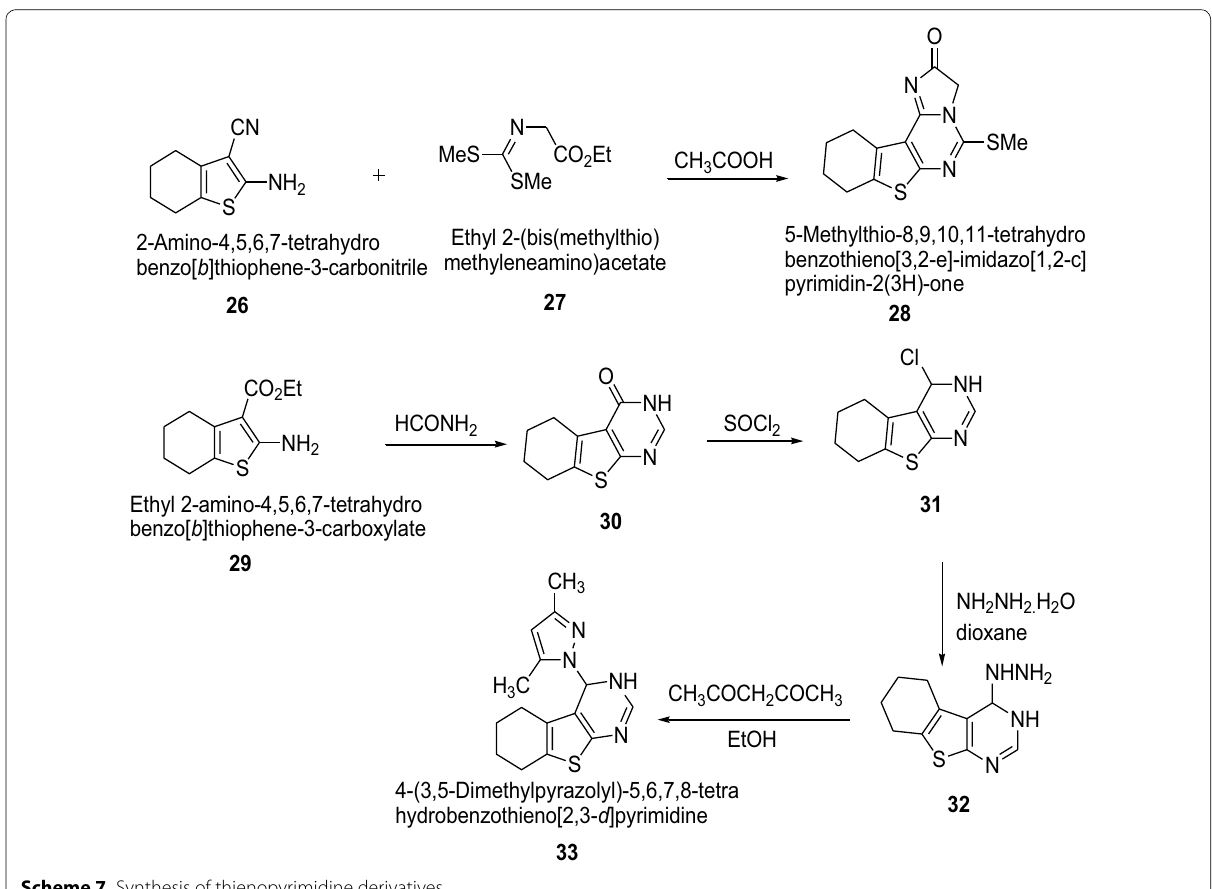
Scheme 7 Synthesis of thienopyrimidine derivatives